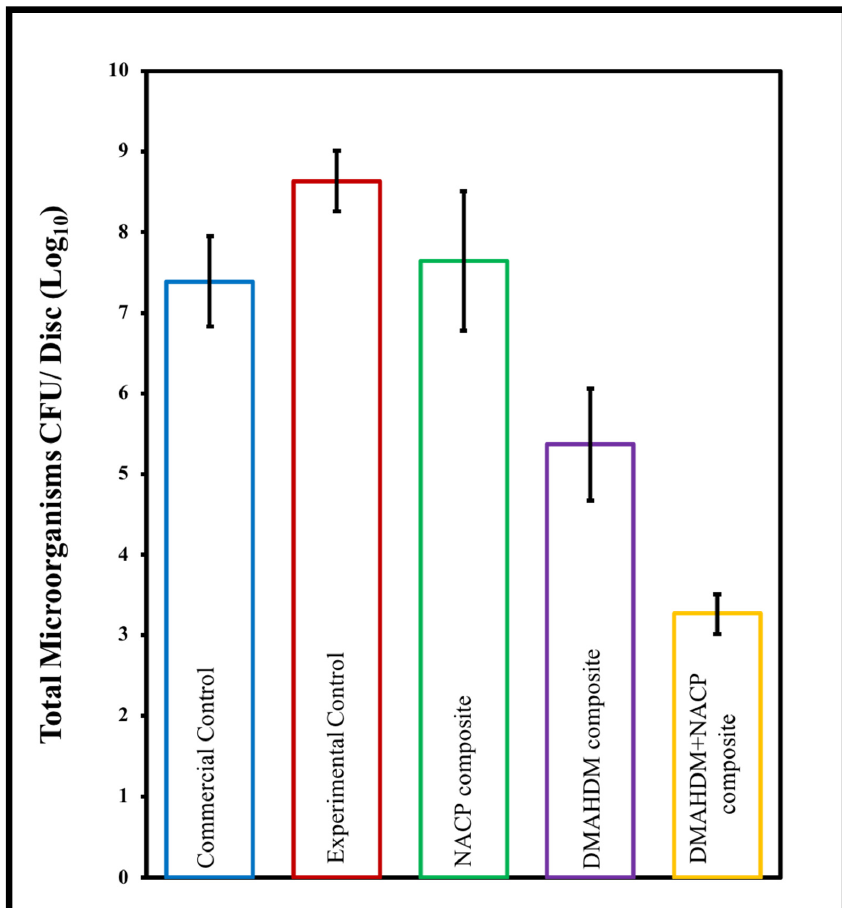
Figure 5. Mutans streptococci of 2-day biofilm colony forming units CFU. Dissimilar letters indicate values that are significantly different from each other ( p < 0.05). Notice that groups with antibacterial agent DMAHDM have the more bacterial log reduction. Commercial Control composite (High- viscosity Sealant/Flowable Composite Virtuoso, DenMat, Lompoc, CA, USA). 50% UV + 50% glass (Experimental Control composite), 45% UV + 20% NACP + 35% glass (UV + NACP composite), 45% UV + 5% DMAHDM + 50% glass (UV+DMAHDM composite), 45% UV + 5% DMAHDM + 20% NACP + 30% glass (UV + DMAHDM + NACP + 30glass), * UV indicates low-shrinkage-stress resin composed of UDMA + TEG-DVBE, Adapted with permission from reference [110]. Copyright 2021